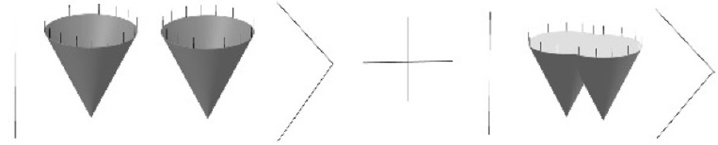
Figure 12 . Two string states are sum of two state vectors as expressed in the (cid:12)gure.